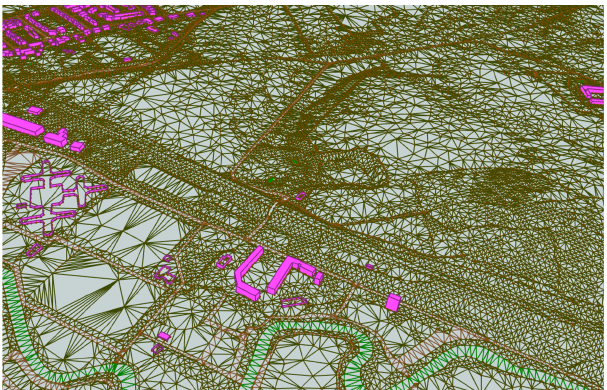
Figure 1: An area of the 3DTOP10NL dataset. Notice that the terrain, the roads, the water courses have all been triangulated, forming one large triangulation for the whole of the